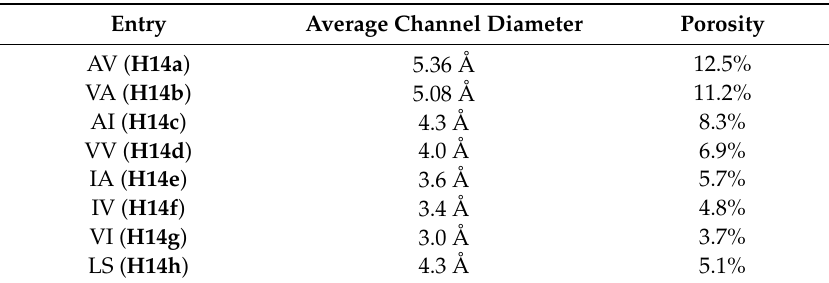
Table 2. Average channel diameter and porosity in H14a – 14h .